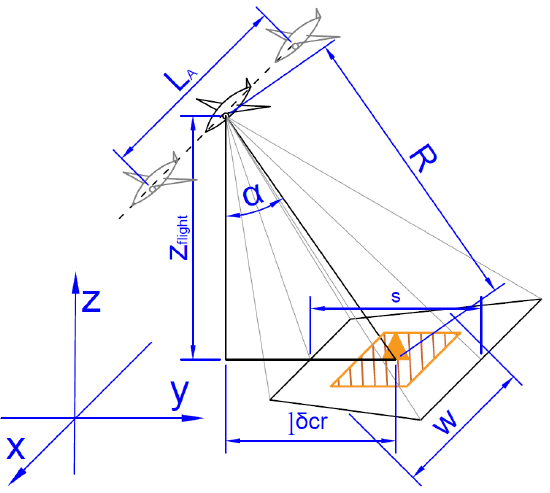
Figure 2. Parameters used for planning SAR radar